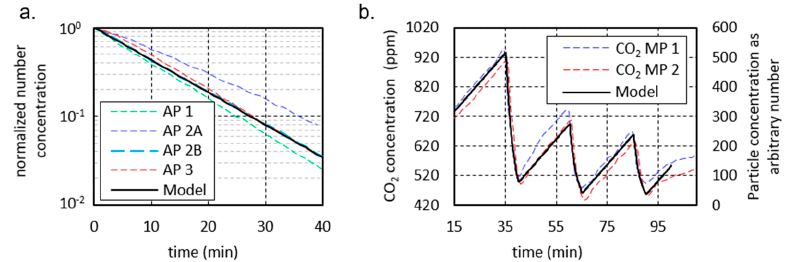
Figure 7. ( a ) Comparison of the AP decay curves between measured and modeled particle concentra- tions; ( b ) Comparison of the measured CO 2 concentration with the modeled particle concentration during a lesson.